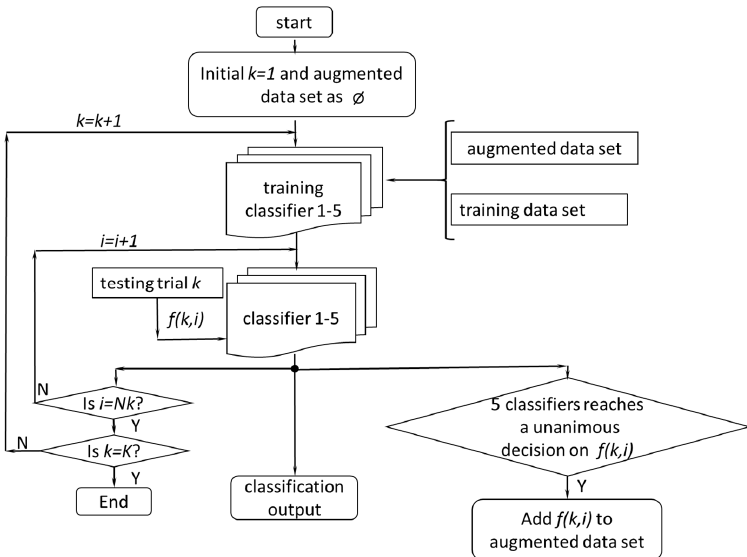
Figure 4. The flow chart for the LIFT. K was the total number of testing trials; Nk was the number of features collected from the k th trial; and f ( k , i ) represented the i th feature in k th trial.